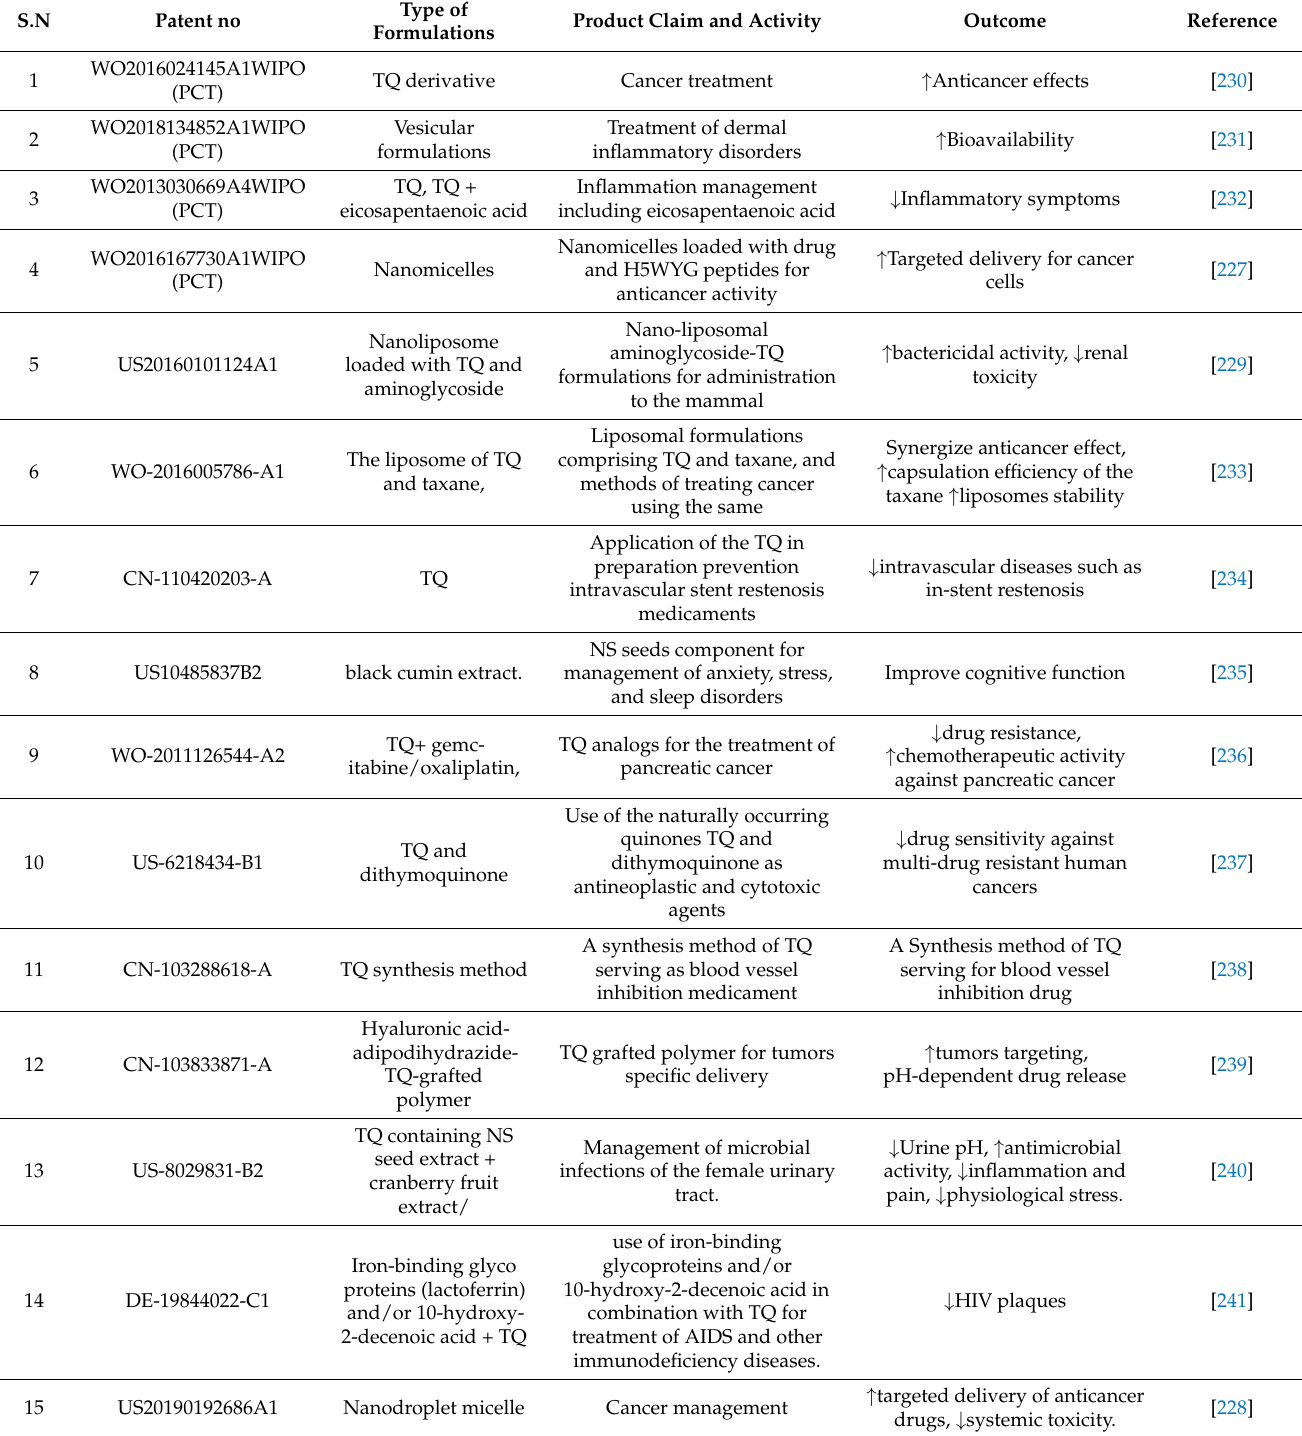
Table 7. Patents of thymoquinone (TQ) and their nanocarrier systems related to inflammation and cancer ( ↓ : decrease, ↑ :